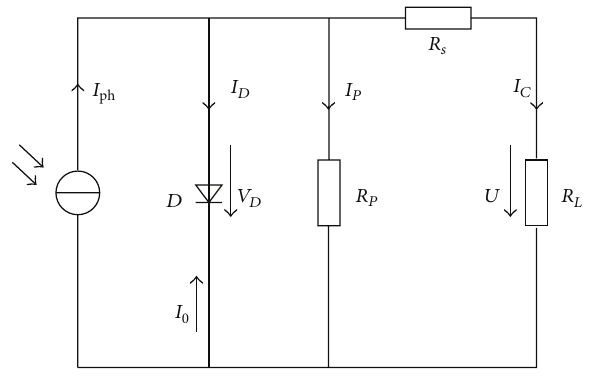
Figure 1: Equivalent circuit of photovoltaic cell.